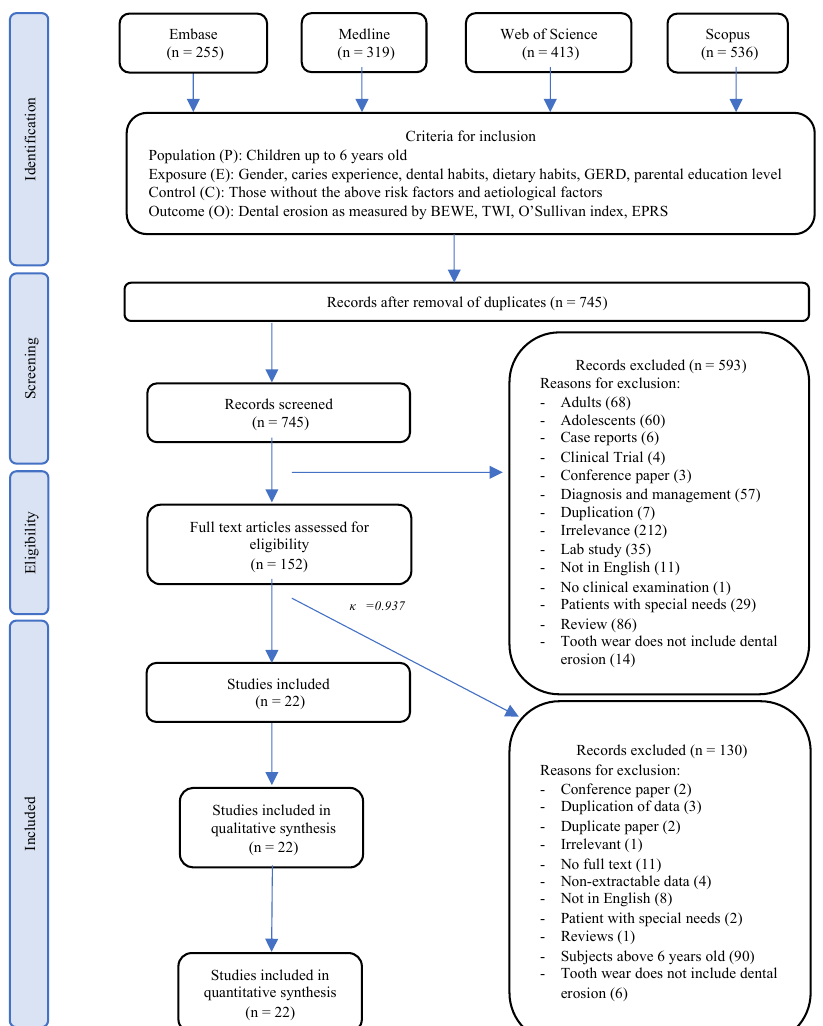
Figure 1. PRISMA flowchart of the screening and study selection process.